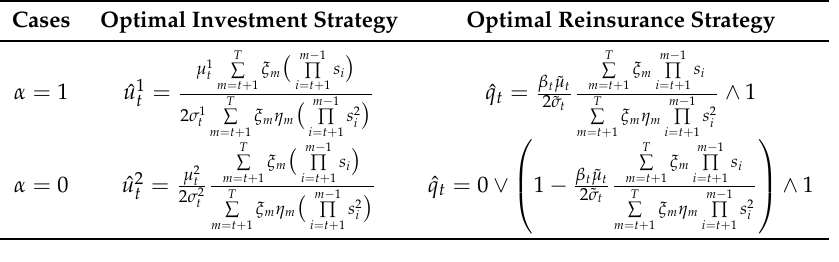
Table 1. Optimal strategy when the expected value premium principle and unilateral interests are considered. Cases Optimal Investment Strategy Optimal Reinsurance